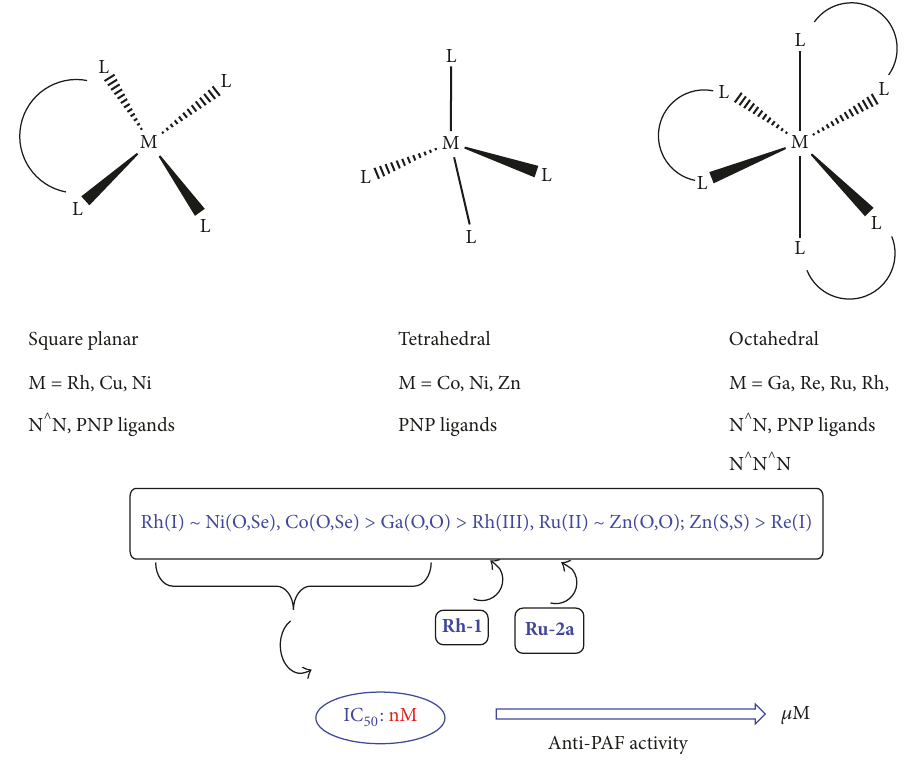
Figure 11: The most potent inhibitors of PAF described in this